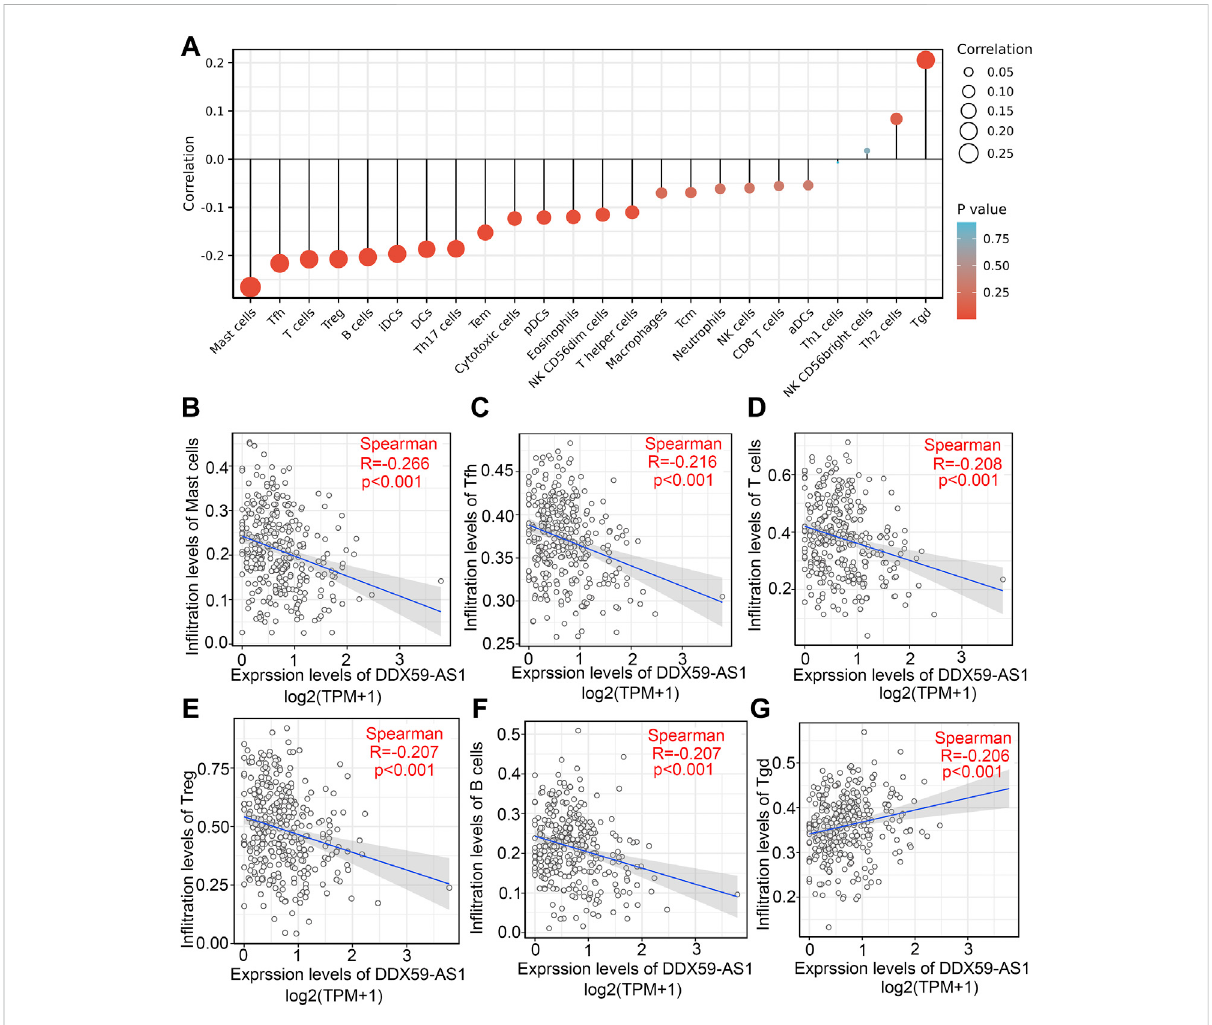
FIGURE 10 The correlation of DDX59-AS1 expression with immune in fi ltration level in OSCC. (A) Correlations between the relative abundance of 24 immune cells and DDX59-AS1 expression levels. The size of the dots represents the absolute Spearman ’ s correlation coef fi cient values; (B – F) DDX59-AS1 expression signi fi cantly negatively correlates levels of Mast cells, Tfh, T cells, Treg, and B cells; (G) DDX59-AS1 expression signi fi cantly positively correlates levels of